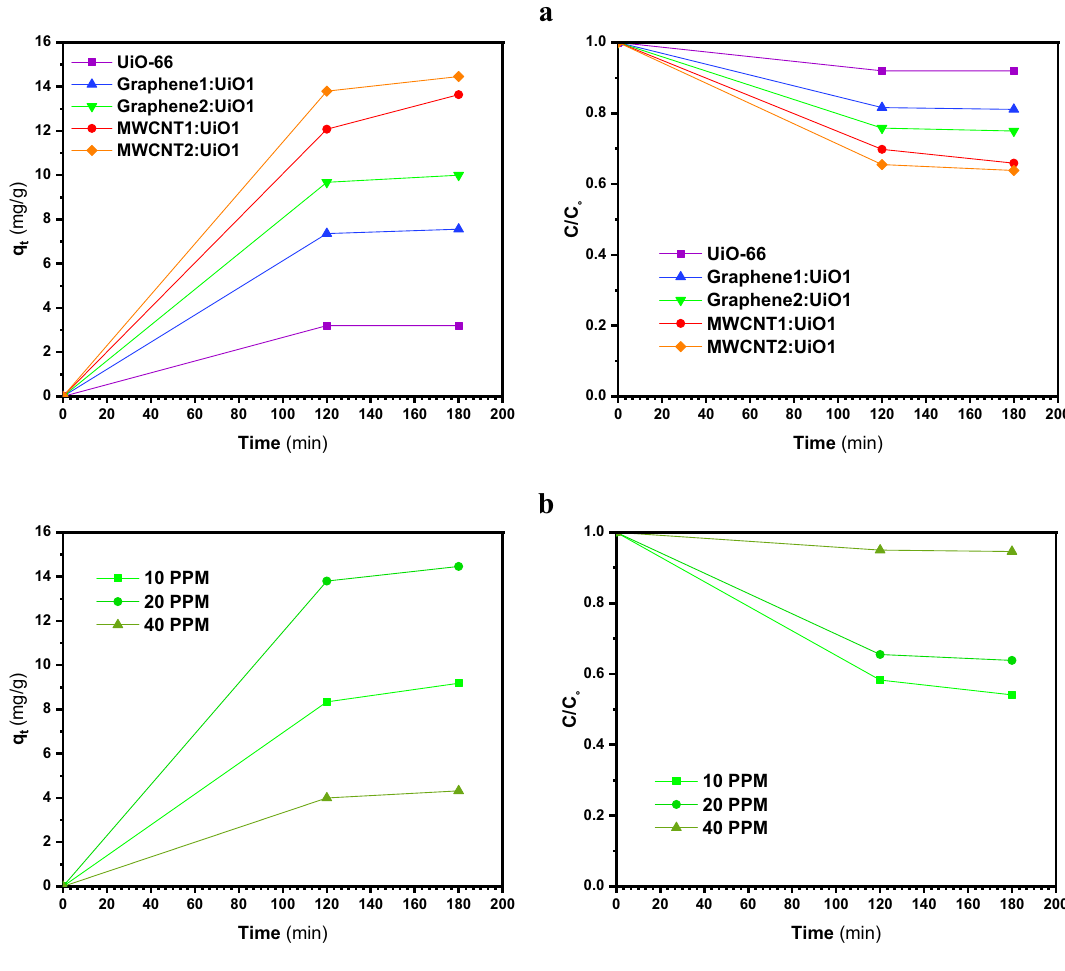
Figure 9. ( a ) Adsorption capacity and solution concentration versus contact time of MG 20 ppm, and ( b ) impact of MWCNT2:UiO1 on MG.